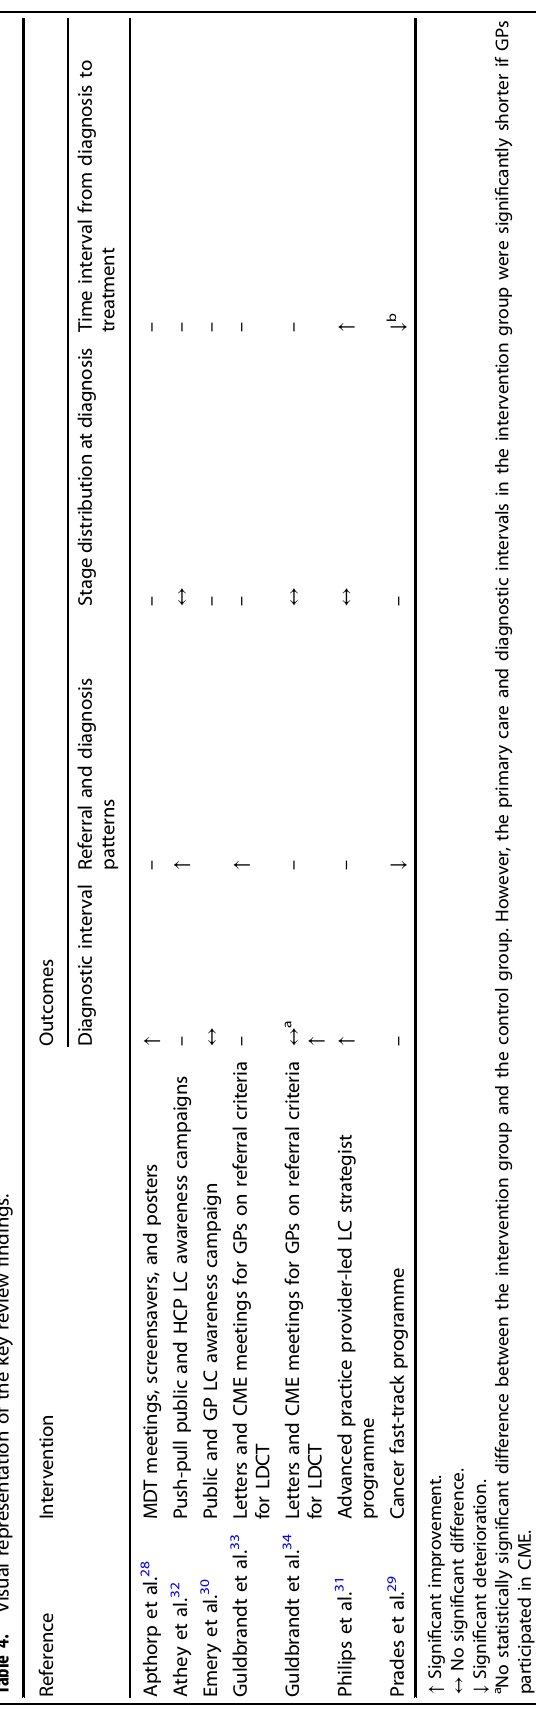
p = 0.08), median number of diagnostic studies obtained (4 vs 5 respectively, p = 0.01), median time from suspicious radiological fi ndings to diagnosis (30.5 vs 48 days respectively, p = 0.02), and median time from suspicious radiological fi ndings to treatment (40.5 vs 68.5 days respectively, p = 0.02) 31 . Moreover, time from suspicious radiological fi ndings to surgical resection was signi fi - cantly shorter in patients managed through the programme in comparison to routine referral (38 vs 69 days respectively, p = 0.05). Among patients with early-stage non-small cell LC treated with radiation therapy, the LC strategist programme led to a substantial reduction in the time from suspicious radiological fi ndings to initiation of treatment in comparison to routine referral (62.5 vs 122.5 days respectively, p = 0.08) 31 . Conversely, in the cancer fast-track programme, Prades et al. 29 noted a variable trend